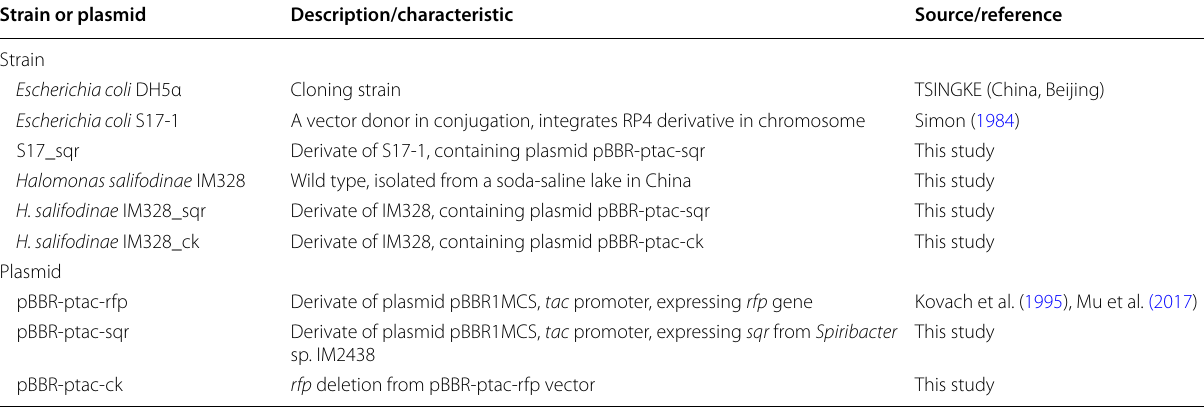
Table 2 Strains and plasmids used in this study Strain or